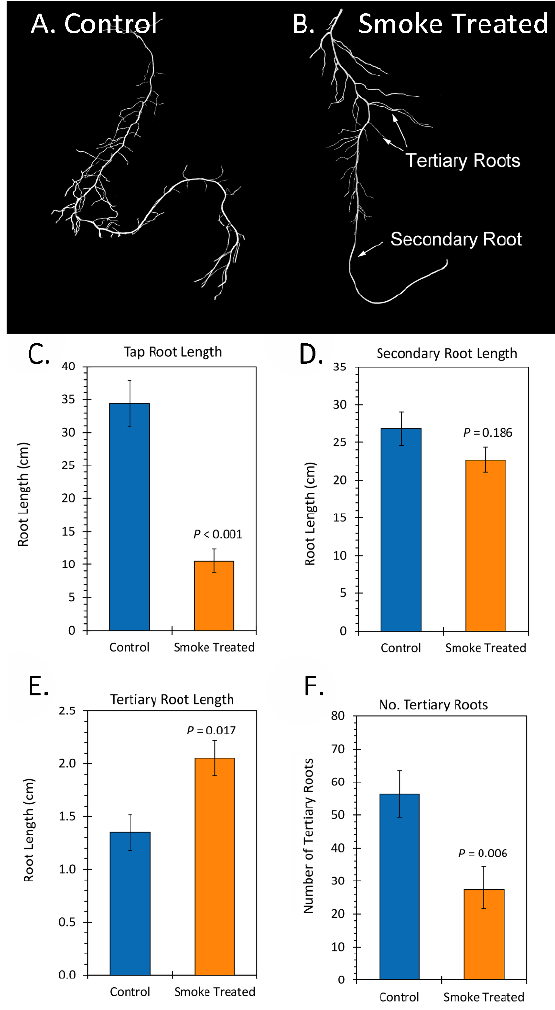
Figure 5. Effect of liquid smoke treatment on sunflower root architecture. Panel ( A , B ): Digital photographs of floated isolated roots from rhizobox studies. Panel ( C ): taproot length in centimeters measured from full rhizobox digital images taken during studies (see Figure 3A,B). Panel ( D ): secondary root length in centimeters measured digitally from floated root images. Panel ( E ): tertiary root length in centimeters measured digitally from floated root images. Panel ( F ): number of tertiary roots tallied per isolated secondary root. All graphical data bars reflect average values ± SE (N = 4). p -values < 0.05 were considered statistically significant.